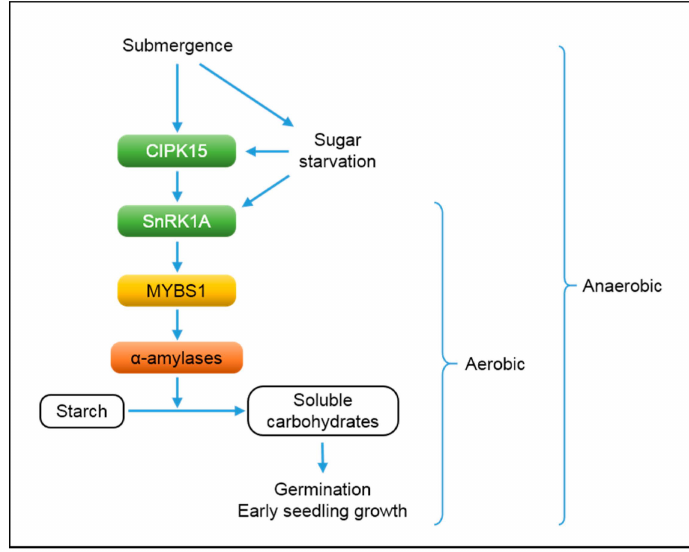
Figure 4. Molecular regulation of germination and early seedling growth in rice under aerobic and anaerobic conditions. Rapid consumption of soluble carbohydrates at the early stage of germination and seedling growth leads to sugar starvation, which stimulates accumulation of an energy sensor protein, SnRK1A [54]. SnRK1A upregulates expression of a MYB transcription factor gene, MYBS1 . MYBS1 protein directly binds to the promoter region of α -amylase genes, activating the conversion of starch into soluble carbohydrates. Under anaerobic conditions such as submergence, the SnRK1A-mediated signaling cascade is triggered by a calcineurin B-like protein-interacting protein kinase15 (CIPK15) [55]. Physical interaction between CIPK15 and SnRK1 proteins activates the downstream signaling components, promoting starch breakdown to support germination and stand establishment under